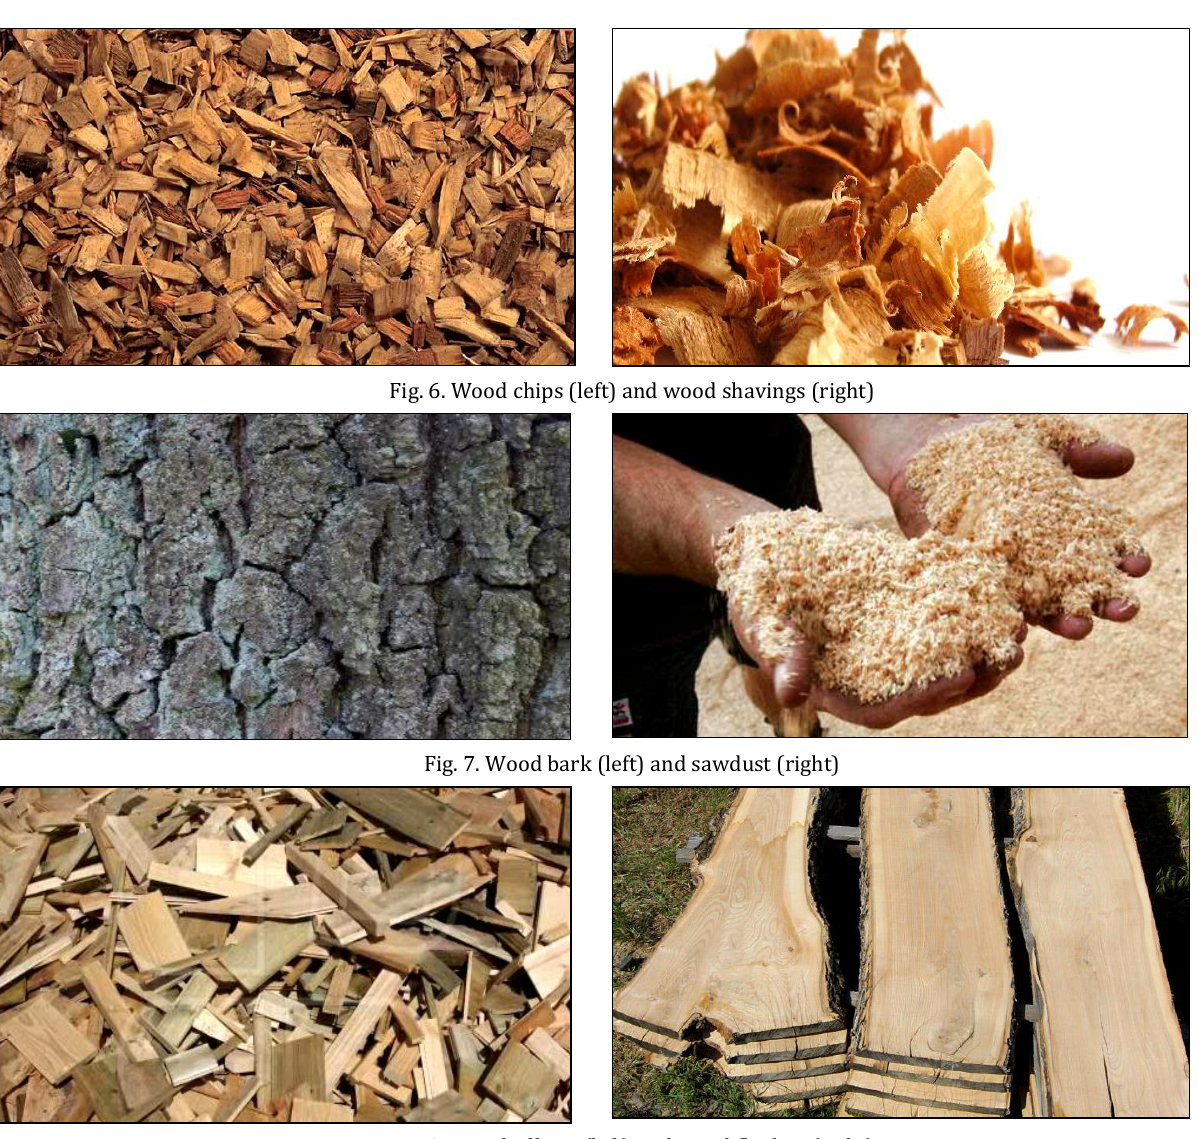
Fig. 8. Wood offcuts (left) and wood flitches